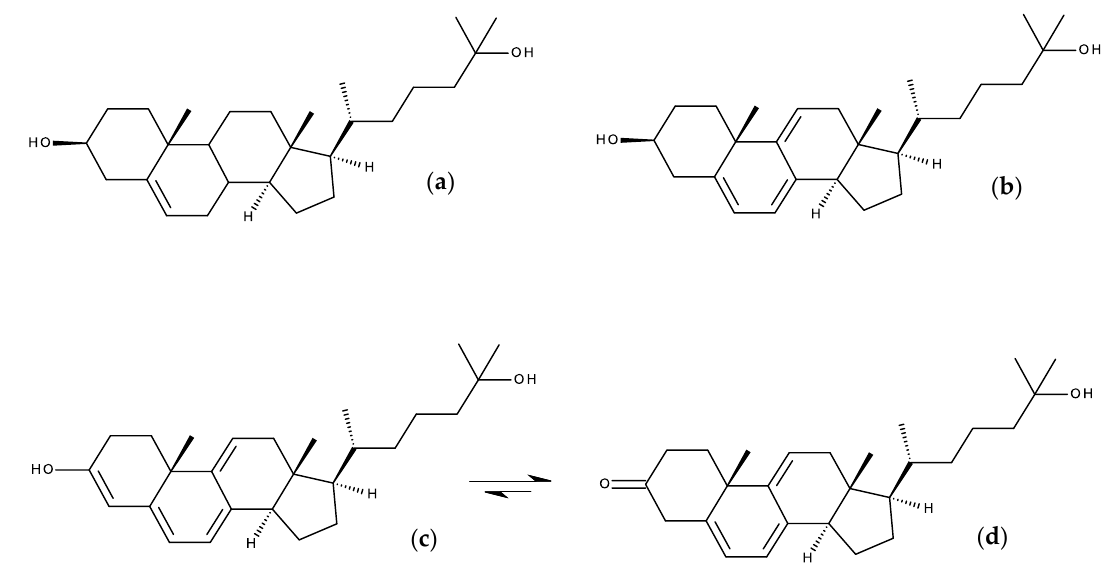
Figure 14. Structures of ( a ) 25-hydroxycholesterol and intrinsically fluorescent analogues: ( b ) 25-hydroxycholestatrienol (25-OH-CTL); ( c ) 25-OH-C4P (enol form); ( d ) 25-OH-C4P (keto form).